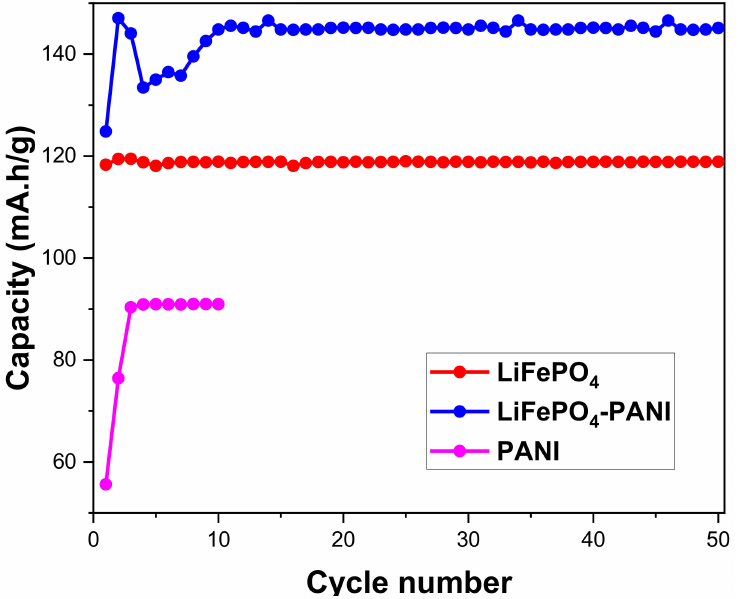
Figure 17. Comparison of discharge cycling performances for the LiFePO 4 –PANI composite and LiFePO 4 . The data were obtained by charging and discharging at 0.1